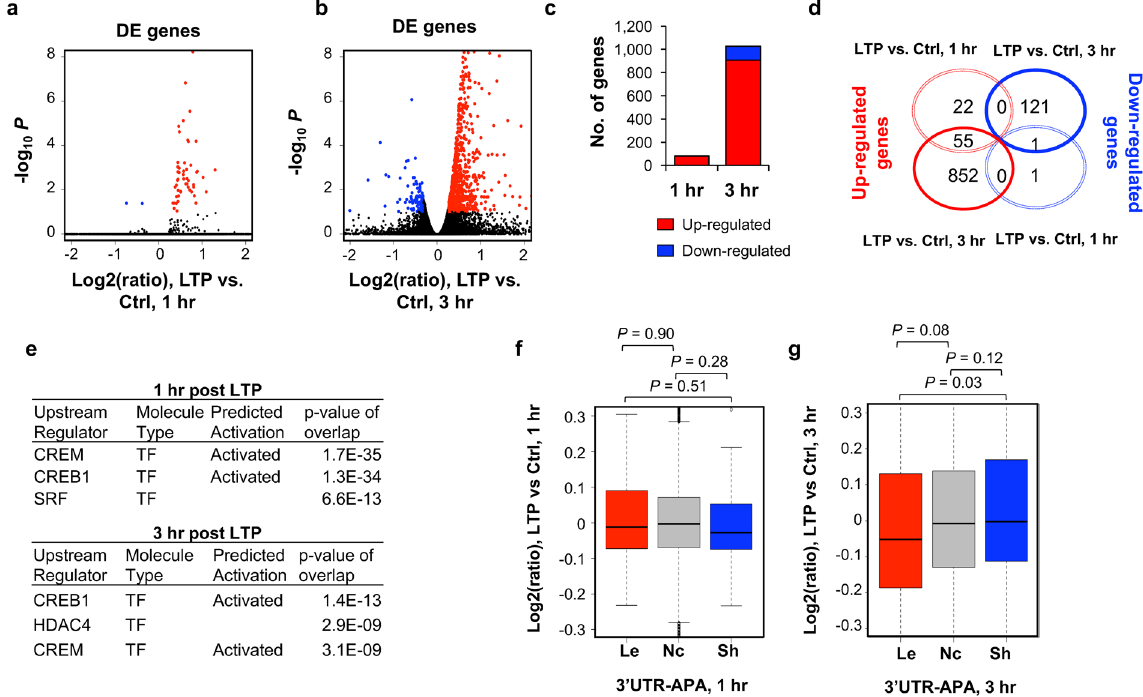
Figure 3. Regulation of gene expression after LTP induction. Differentially expressed (DE) genes 1 hr ( a ) or 3 hr ( b ) post LTP induction, as determined by RNA-seq. X-axis, log2(ratio) of gene expression (LTP vs Control); Y- axis, − log 10 P (DESeq). DE genes were selected based on expression change > 20% and FDR < 0.1. Genes with upregulated expression are highlighted in red and those with downregulated expression in blue. Black dots represent genes without significant regulation. ( c ) Bar graph summarizing DE genes shown in ( a ) and ( b ). ( d ) Venn diagram comparing DE genes at 1 hr LTP and 3 hr LTP. ( e ) IPA upstream regulator analysis for significantly regulated genes. This data is generated through the use of Ingenuity Pathways Analysis, a web- delivered application (www.Ingenuity.com). ( f ) and ( g ) Gene expression regulation vs. LTP-induced 3 ′ UTR- APA regulation. Box plots showing the log2(ratio) of gene expression, LTP vs. Ctrl, for genes with 3 ′ UTR lengthened (Le), shortened (Sh) or no change (Nc) at 1 hr ( f ) or 3 hr ( g ) post LTP induction. Only genes with significant 3 ′ UTR APA regulation (those from Fig. 2) were included. P-values (Wilcoxon rank sum test) indicate difference between gene